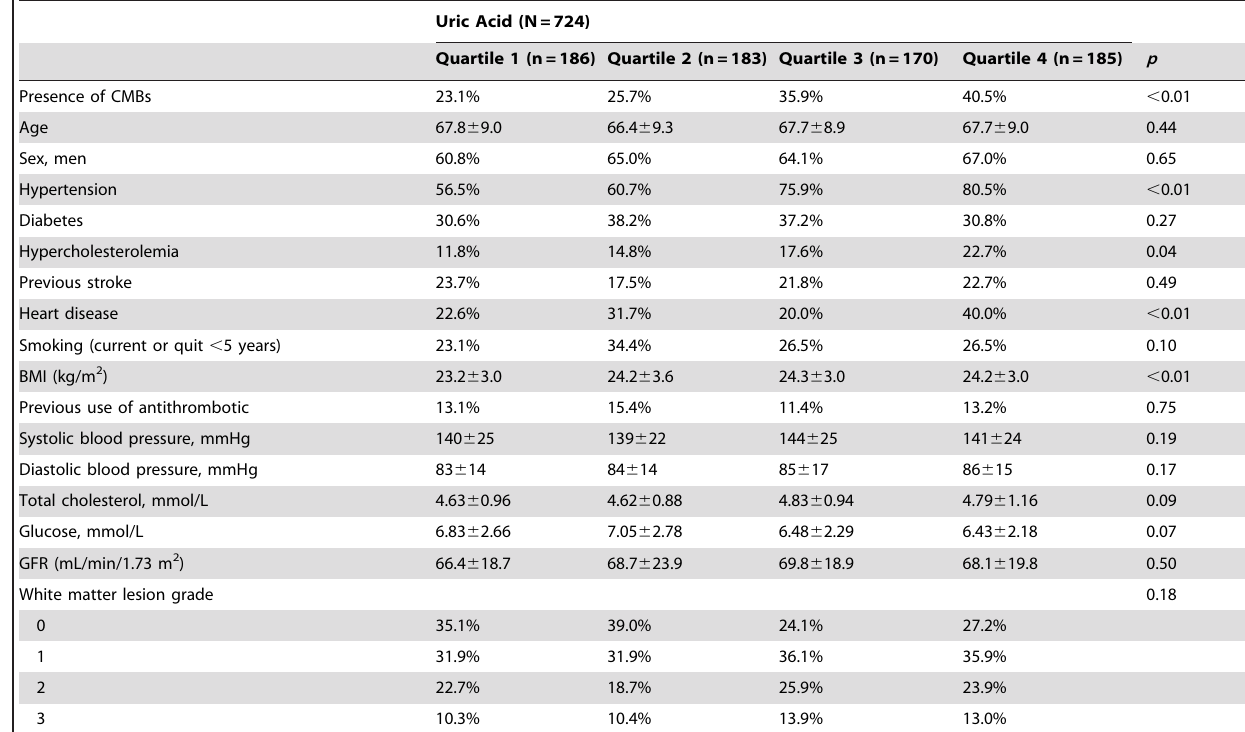
Table 2. Baseline Characteristics of Patients across Sex-Specific Quartile of Uric